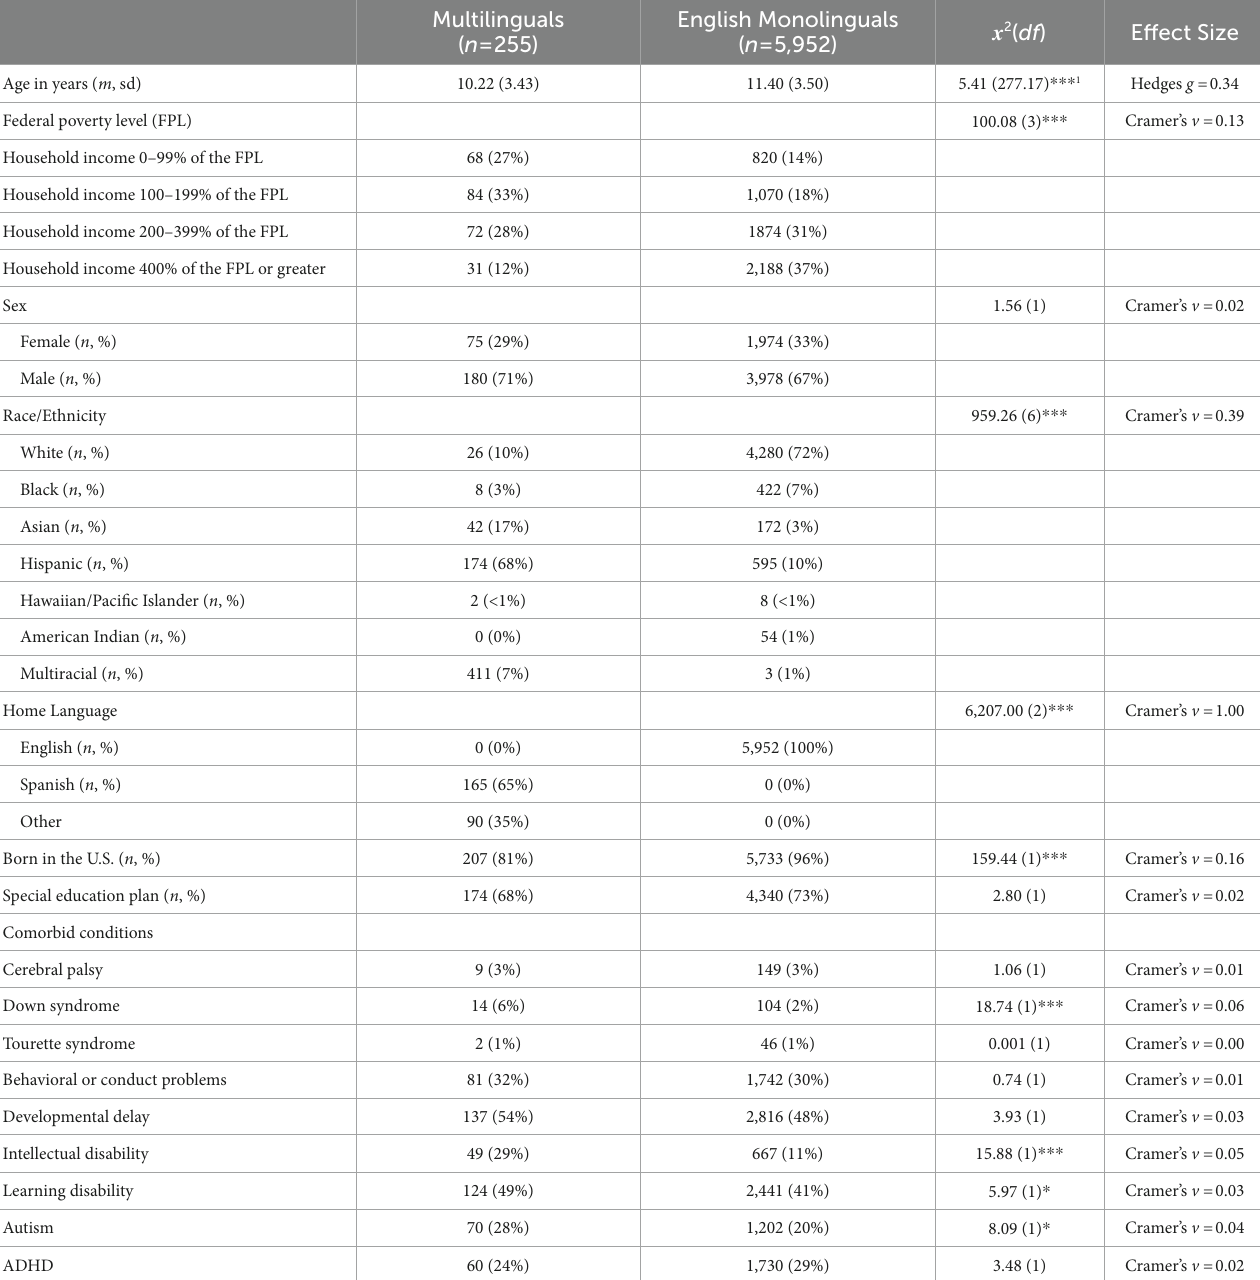
TABLE 1 Sample’s demographic characteristics by group with tests of between group